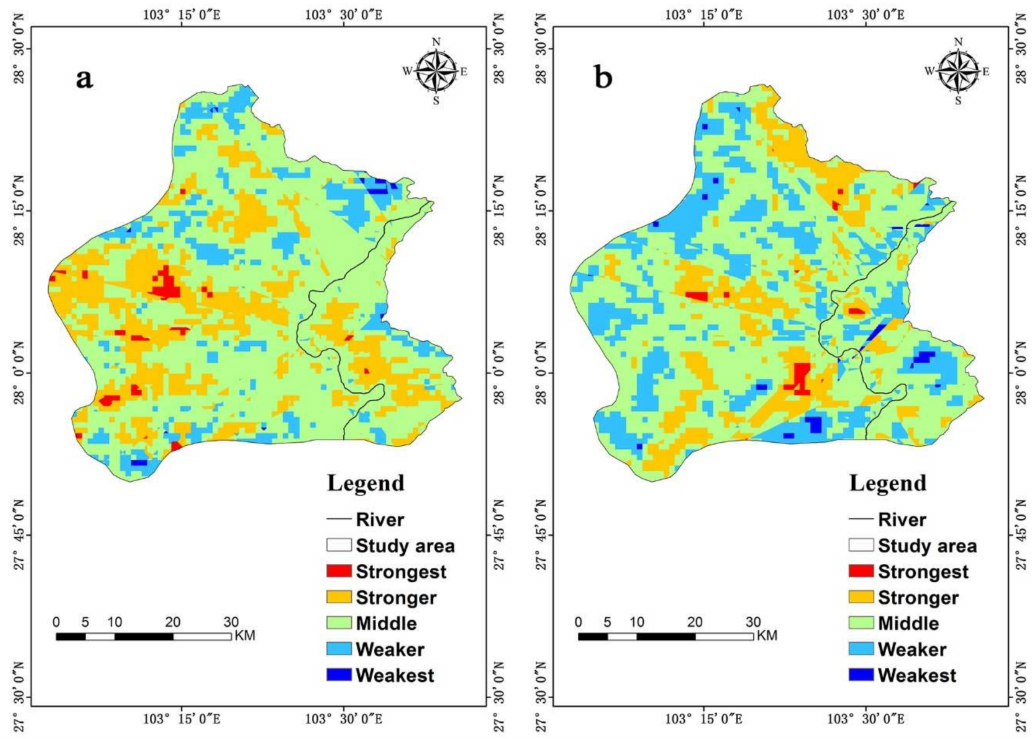
Figure 5. ( a ) Spatial distribution of NRECI class in wet season; and ( b ) spatial distribution of NRECI class in dry